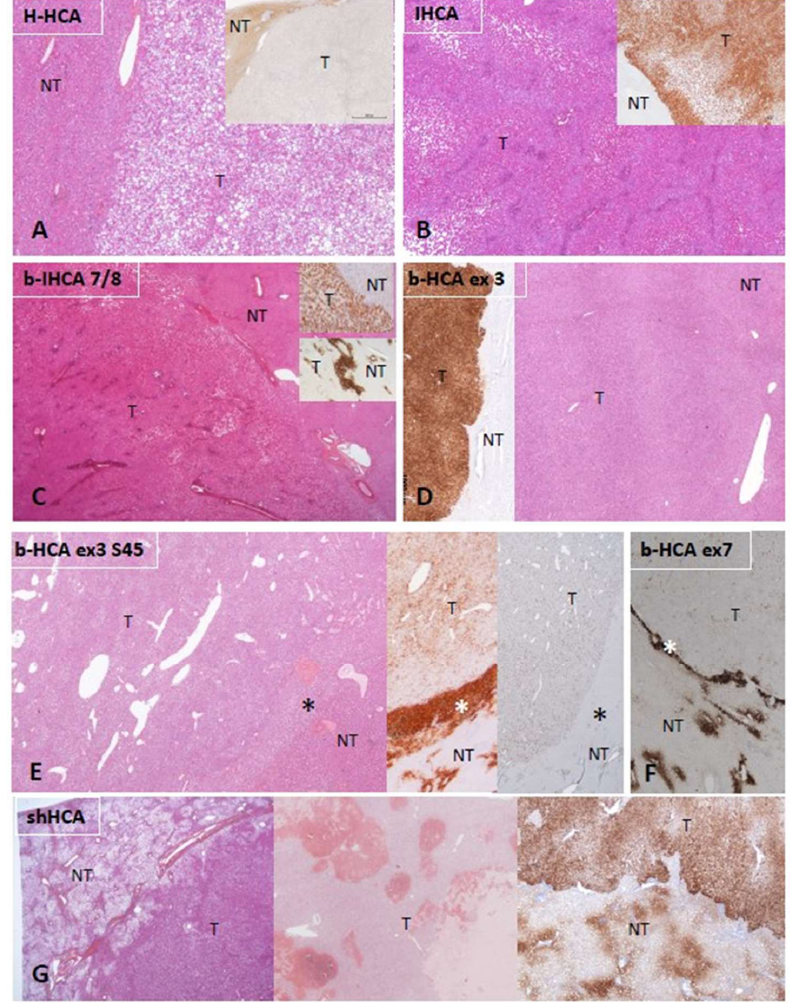
Figure 1. Characteristic histologic and immunohistochemical features of HCAs. ( A ) H-HCA: The tumor (T) appears highly steatotic on H&E with a complete lack of LFABP by immunohistochemistry (insert), contrasting with the normal expression in the nontumorous liver (NT). ( B ) IHCA: The tumor (T) exhibits sinusoidal dilatation on H&E with a strong CRP expression by immunohistochemistry (insert), sharply demarcated from the nontumorous liver (NT). ( C ) CTNNB1 exon 7/8 mutated b-IHCA: This tumor exhibits a classical appearance of IHCA (sinusoidal dilatation, numerous thick arteries, and strong expression of CRP (top insert); in addition, GS is very faint in the tumor but with a strong GS rim between tumor (T) and nontumorous liver (NT) (bottom insert); molecular analysis identified a mutation on CTNNB1 exon 7/8 (see [2]). ( D ) CTNNB1 exon 3 mutated b-HCA: This tumor (T), which is not well delimited from the nontumorous liver (NT) on H&E, exhibits a strong and diffuse GS expression (left insert), identifying a high level of activation of the β-catenin pathway (large deletion on exon 3). ( E ) Exon 3 S45 mutated b-HCA: This tumor (T) exhibits numerous irregular vessels below the rim (asterisk) that separates T from nontumorous liver (NT); heterogeneous expression of GS is seen in T, whereas a strong GS expression characterizes the rim (middle insert); a corresponding diffuse CD34 immunostaining is seen in the endothelial cells of T, with no CD34 expression in the rim (asterisk) (right insert) (see [2]). ( F ) Exon 7 mutated b-HCA: GS is very faint in the tumor (T), and a thin GS rim (asterisk) separates T from the nontumorous liver (NT); molecular methods identified a β-catenin exon 7 mutation. ( G ) shHCA: This tumor developed in a highly steatotic nontumorous liver (NT, left picture) and exhibits focally large hemorrhagic foci